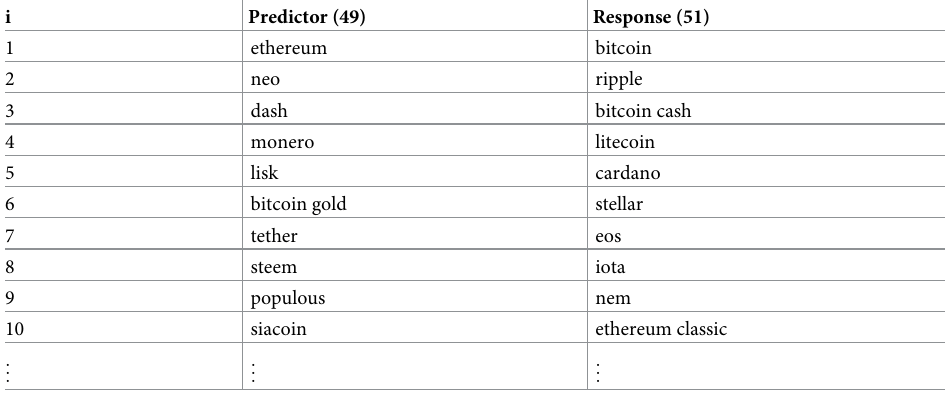
Table 2. Predictor and response